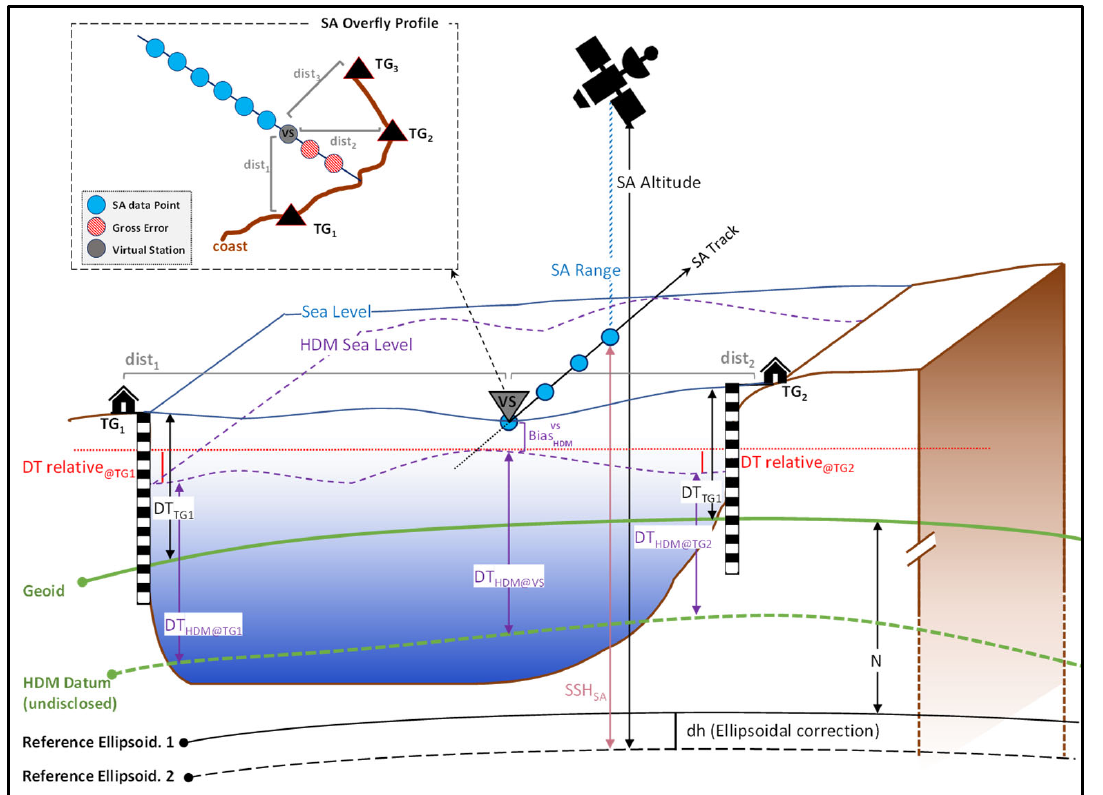
Figure 1. Inter-relations between the participating datasets (hydrodynamic model, tide gauges, and satellite altimetry data), geoid model, and different reference ellipsoids. Virtual Station (VS) is used to correct the HDM near the TG. The top inset illustrates the VS selection principles along the SA tracks.